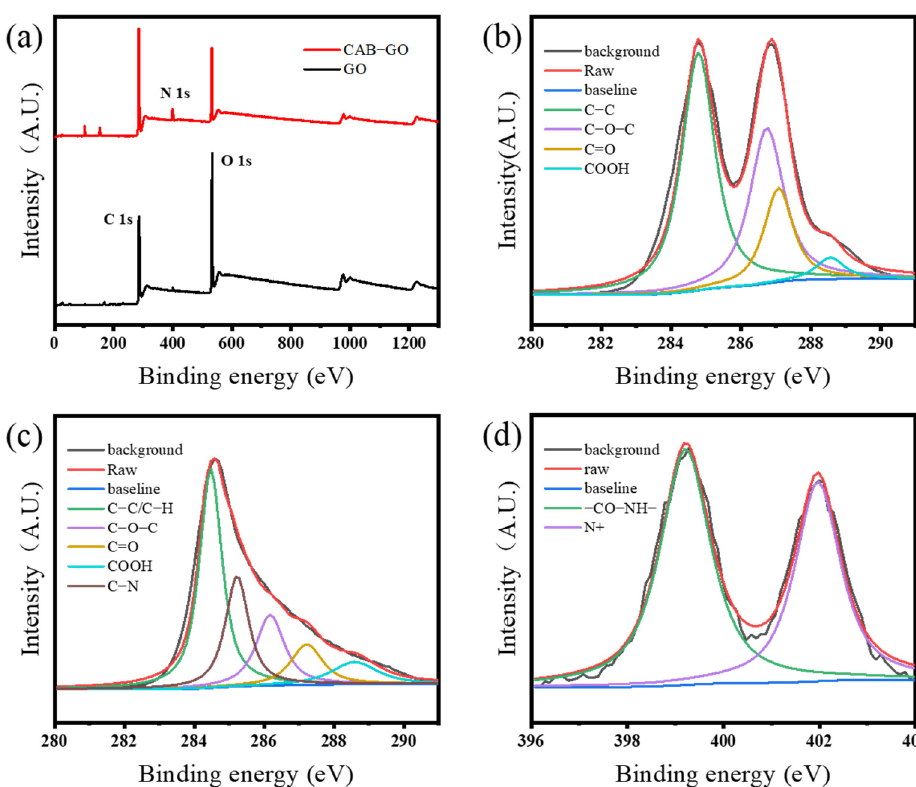
Figure 5. XPS full spectra of GO and CAB − GO ( a ), C 1s spectrum of GO ( b ), CAB − GO ( c ) and N 1s spectrum of CAB − GO ( d ).